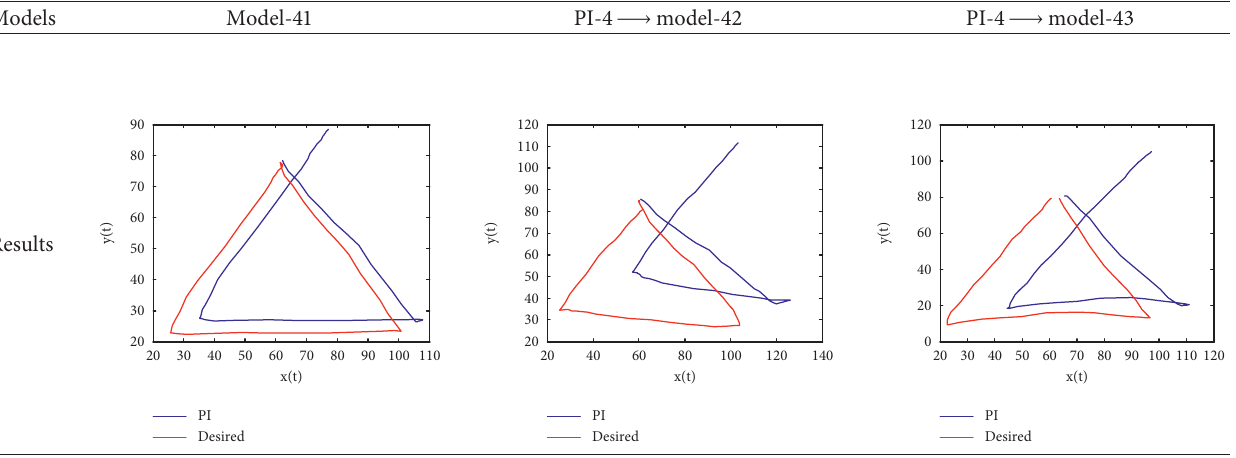
Table 7: Results of validation of the PI-3 controller applied to model-41, model-42, and model-43.